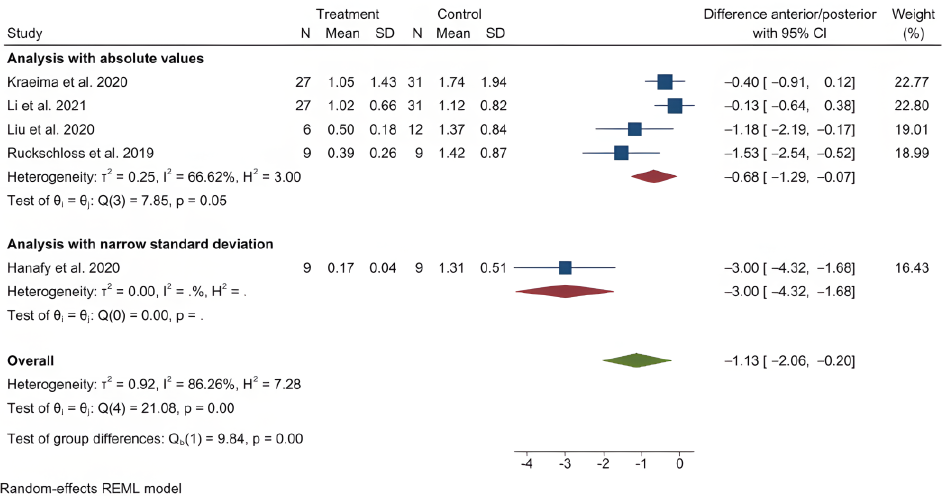
Figure 10. Forest plot showing differences in antero-posterior deviation between PSI and control (conventional osteosynthesis and CAD/CAM splint or wafer).